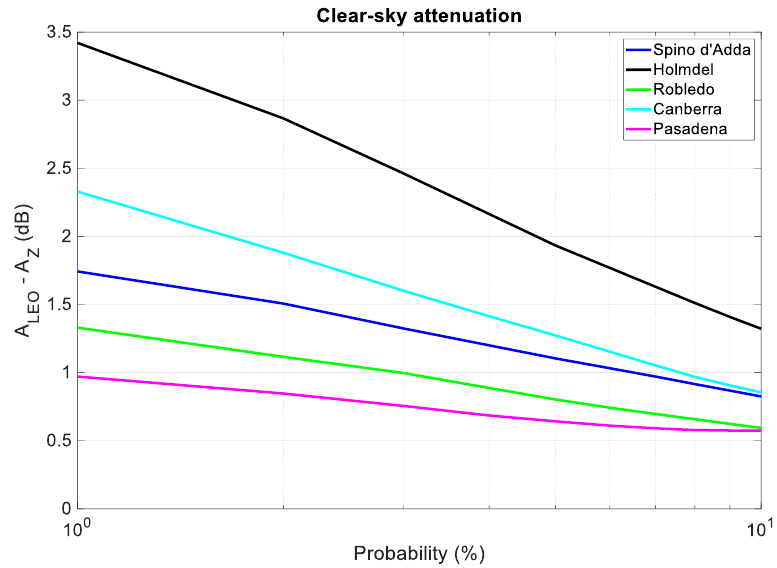
Figure 15. The difference 𝐴 𝐿𝐸𝑂 − 𝐴 𝑍 , calculated, at equal probability, in the probability range 1% to 10% between the clear-sky attenuation exceeded in the LEO path, 𝐴 𝐿𝐸𝑂 , and that exceeded in the GeoSurf path, 𝐴 𝑍 , in the reference sites.